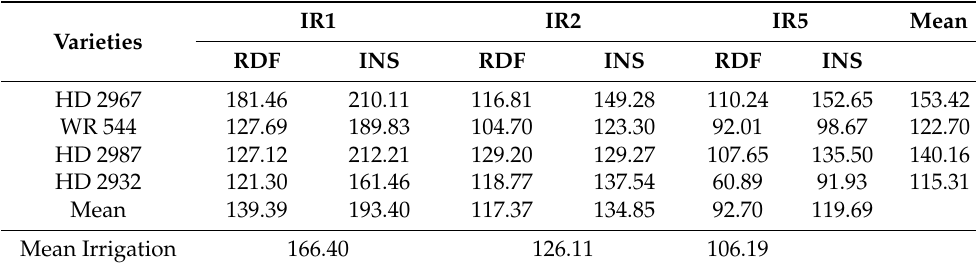
Table 10. Interaction effect of nutrient management levels, irrigation schedules, and varieties on available nitrogen